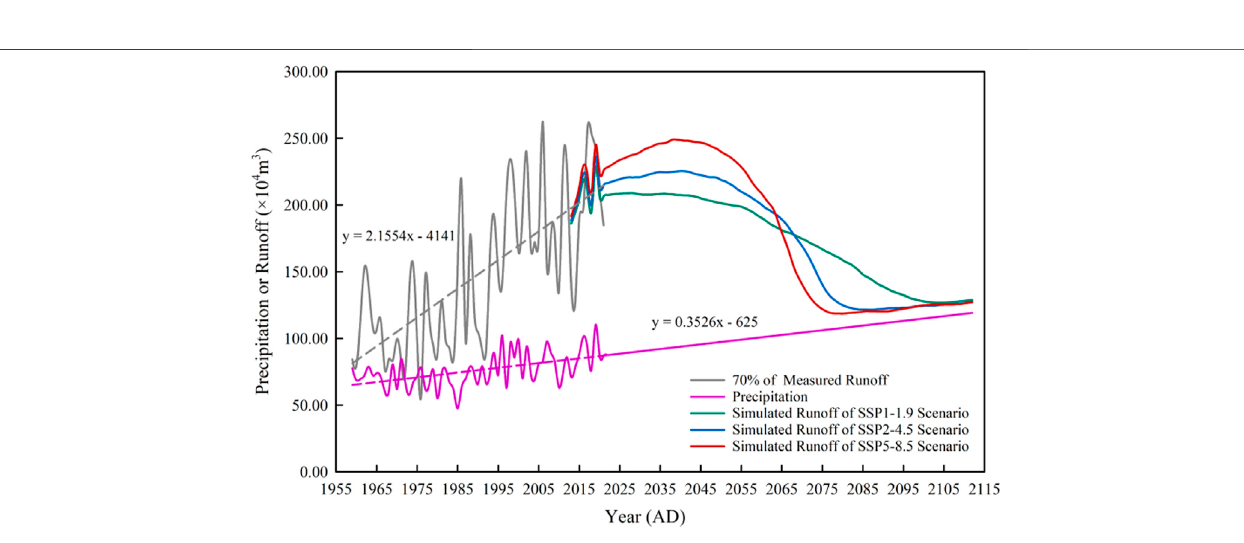
FIGURE 13 | Simulated glacier runoff in the three climate scenarios that compared with measured runoff.